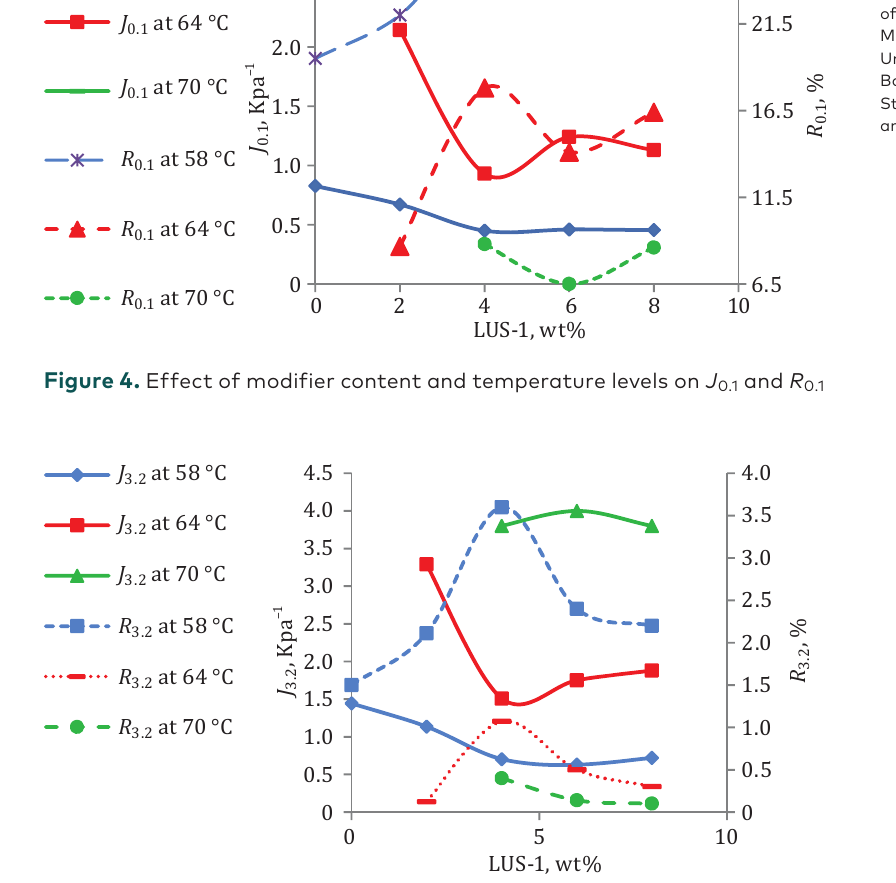
Figure 5. Effect of modifier content and temperature levels on J 3.2 and R